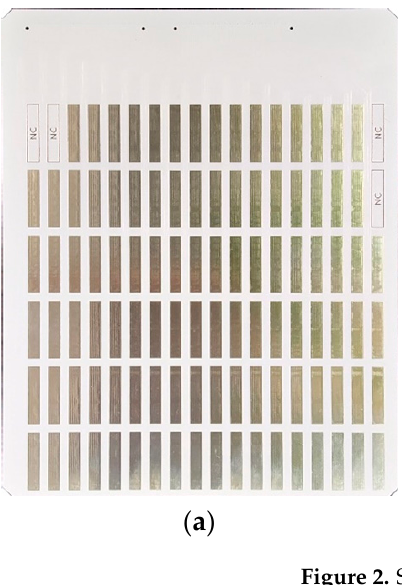
Figure 1. The proposed system: ( a ) Motherboard and connected Sensor Board; ( b ) Gesture recogni- tion pipeline.